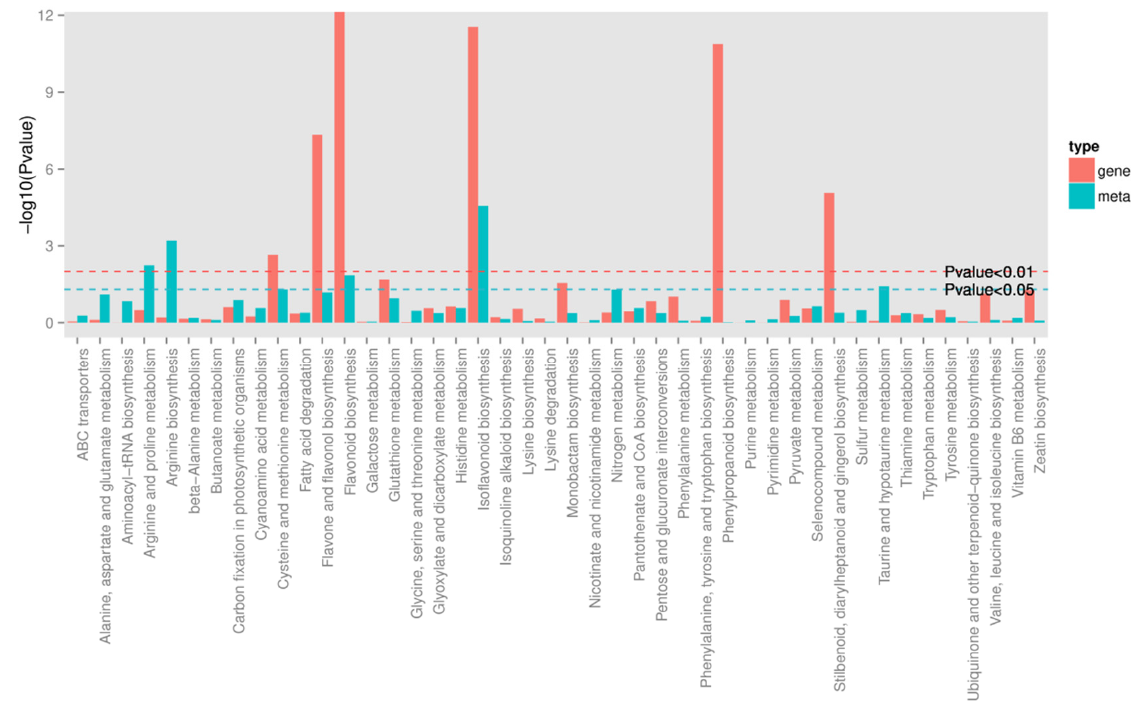
Figure 5. Joint analysis of the differentially expressed genes and differentially accumulated metabolites between S_CK and S_T. Green line represents the selected gene and metabolic pathway at p -value < 0.05, and red line represents the selected gene and metabolic pathway at p -value < 0.01.